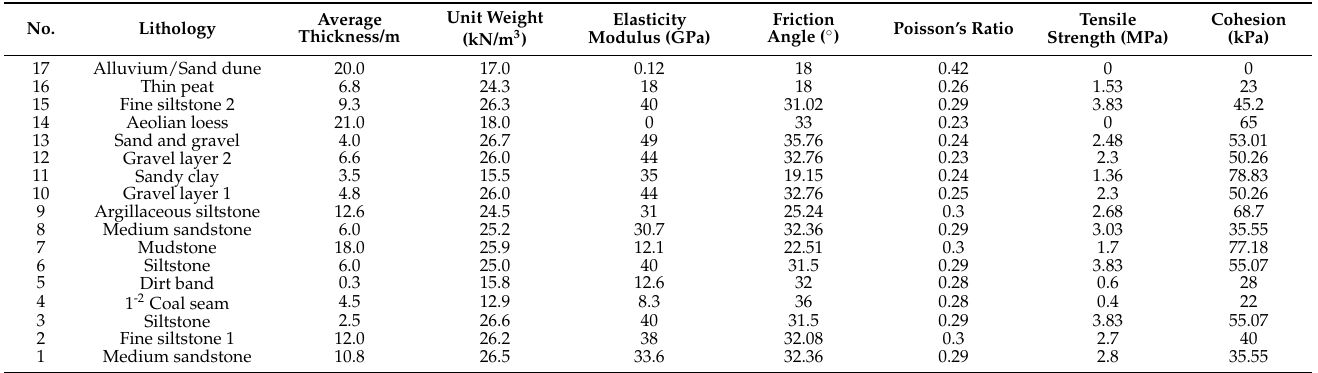
Table 1. Mechanical and physical properties of the simulated blocks of 12311 longwall panel overlying coal rock.